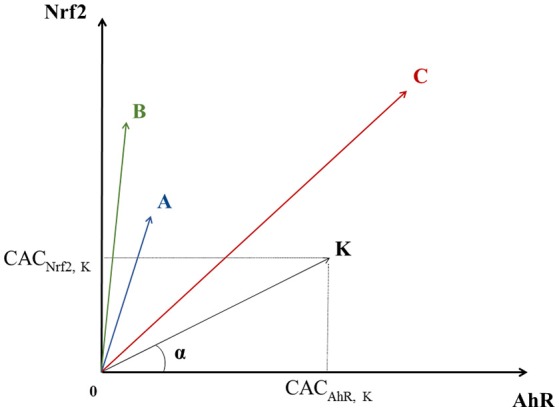
Geometric representation of chemical specificity and potency for the Nrf2 and AhR pathways. K represents a chemical and its coordinates are (CACAhR, K, CACNrf2, K). K also defines the vector OK→ linking the origin O (0, 0) to point K. The absolute value of the cosine of the angle α between OK→ and a pathway's axis can be used to measure the specificity of a chemical for the given pathway (the smaller α, the more specific the chemical). On the other hand, the overall activation potency of a chemical increases proportionally with the length of OK→. Points A, B, and C represent three other chemicals with different specificities and potencies for pathways' activation (see text).